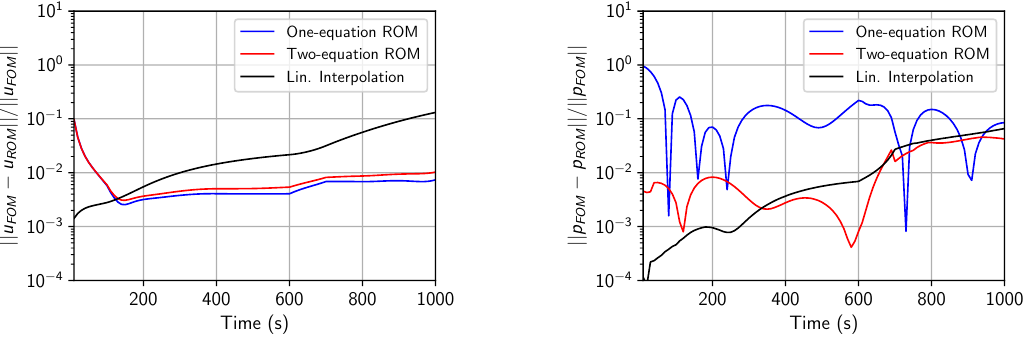
Figure 3: Velocity and pressure errors as function of time for the one- and two-equation